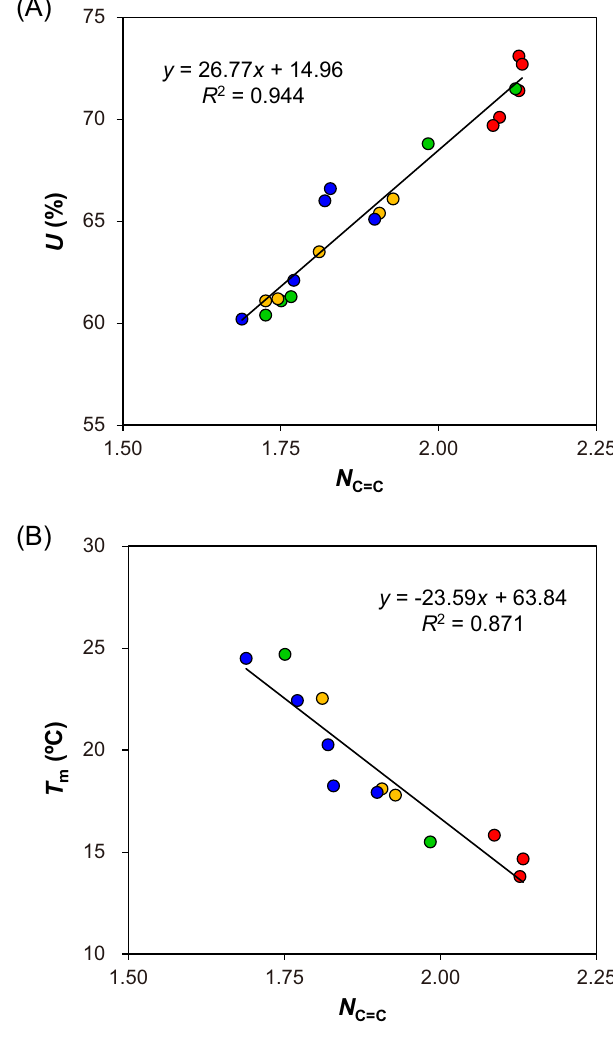
Figure 3. Correlation of the unsaturation degree of TAG ( N C = C ) with ( A ) the ratio of unsaturated fatty acids ( U ) and ( B ) the melting point ( T m ) of the sirloin samples. The plots are color-coded according to brand: A, red; B, green; C, yellow; and D,